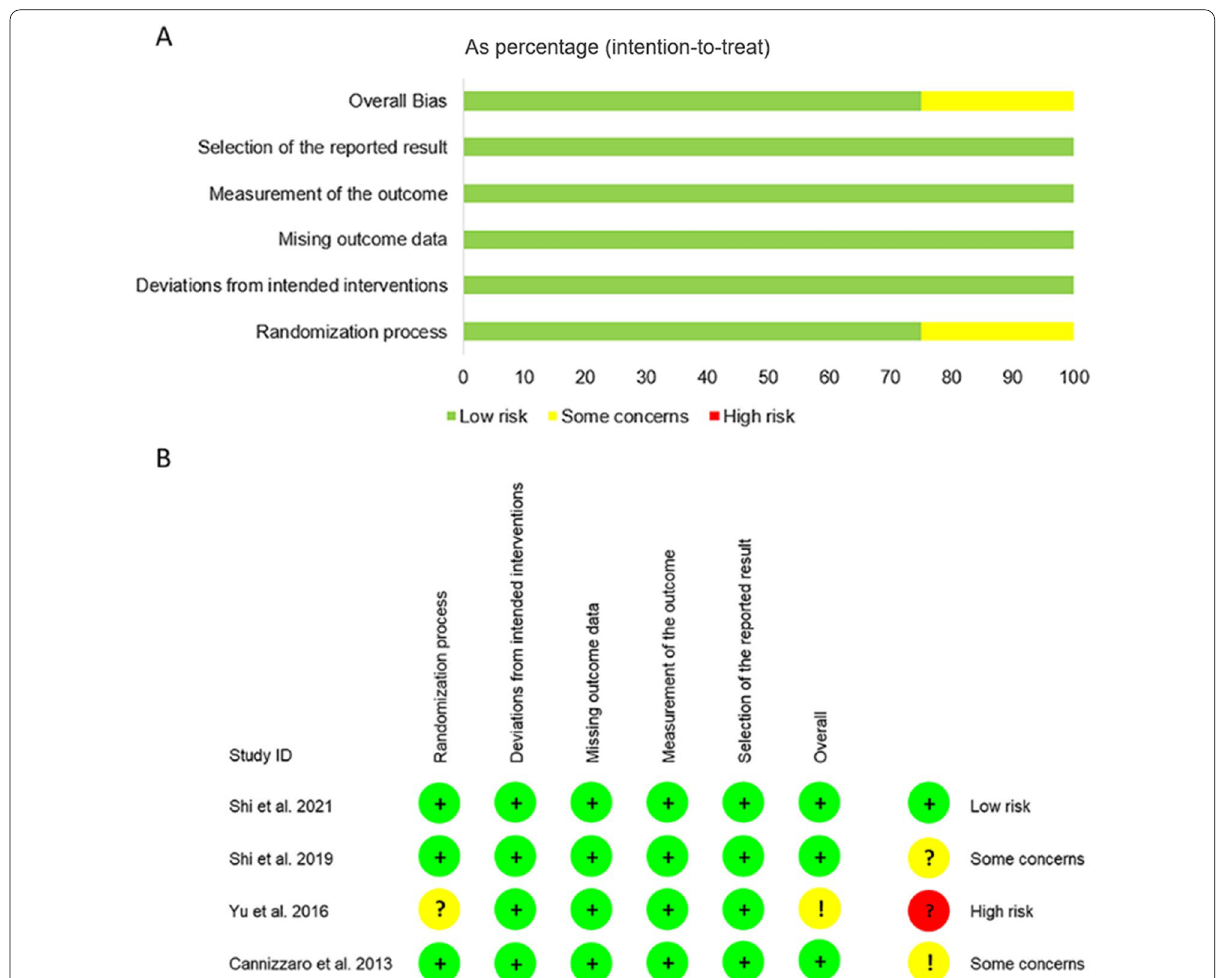
Fig. 2 Risk of bias for included RCTs. A Each risk of bias item presented as percentages across the randomized controlled trials. B Each risk of bias item for each randomized controlled